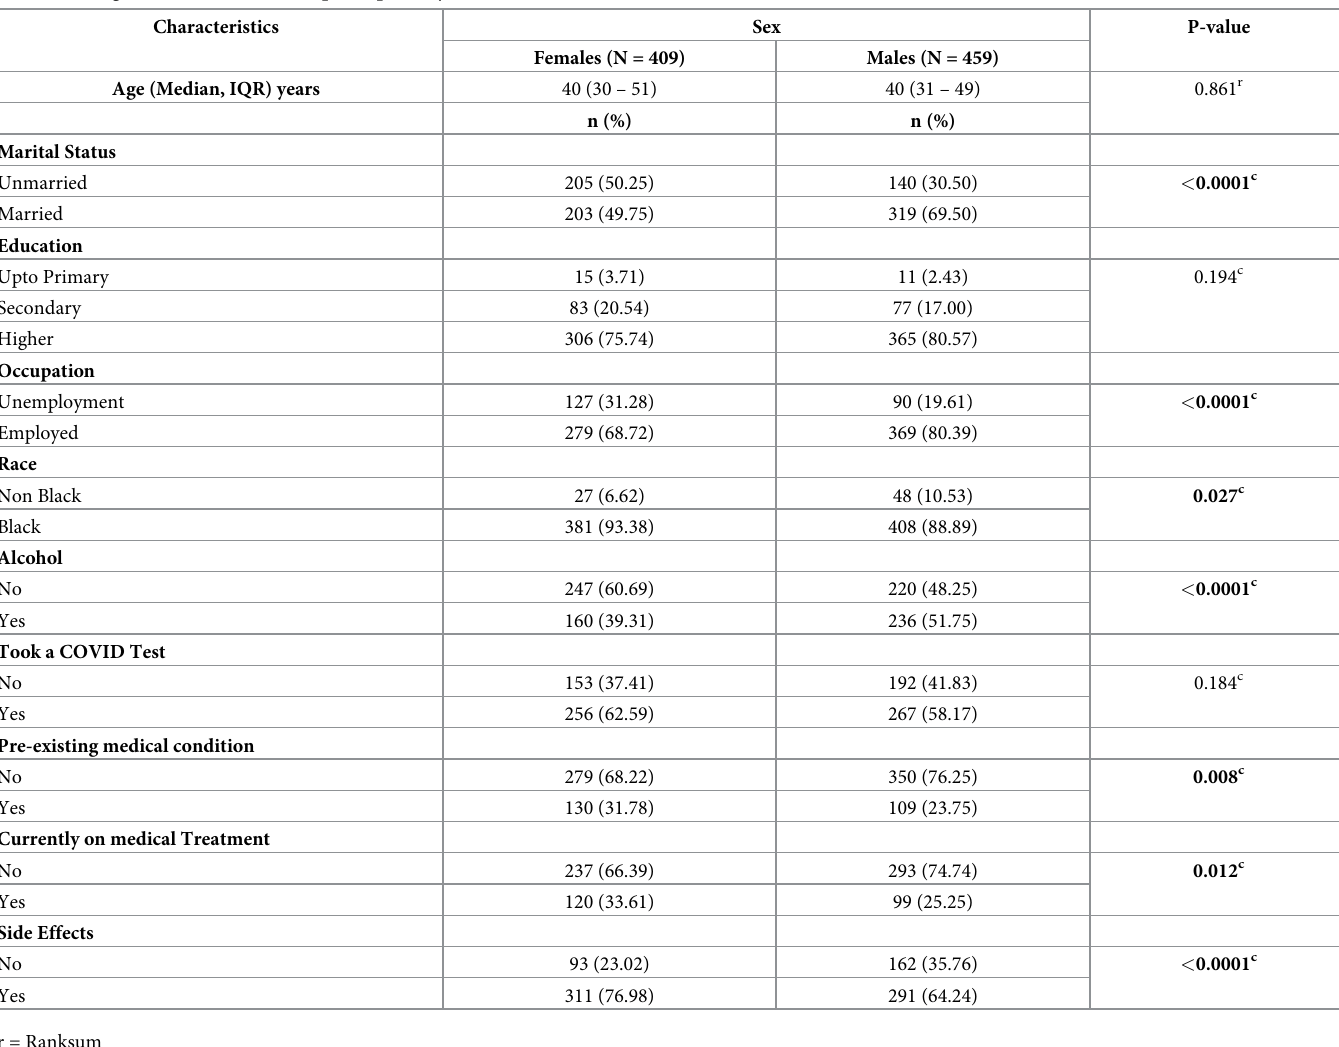
Table 1. Background characteristics of participants by